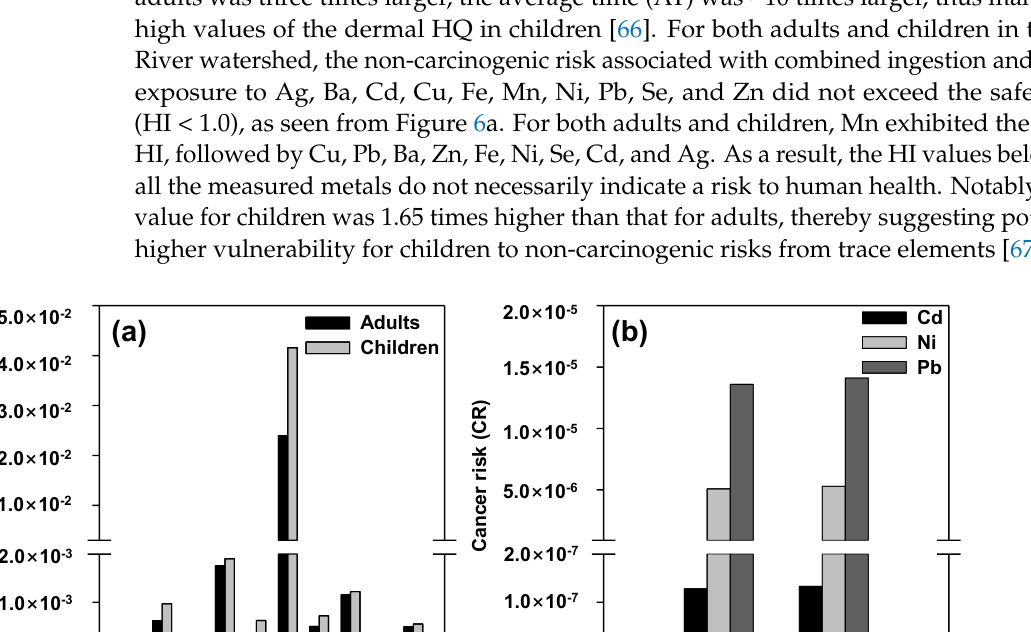
1.64 × 10 − 2 for adults and 3.37 × 10 − 2 for children.